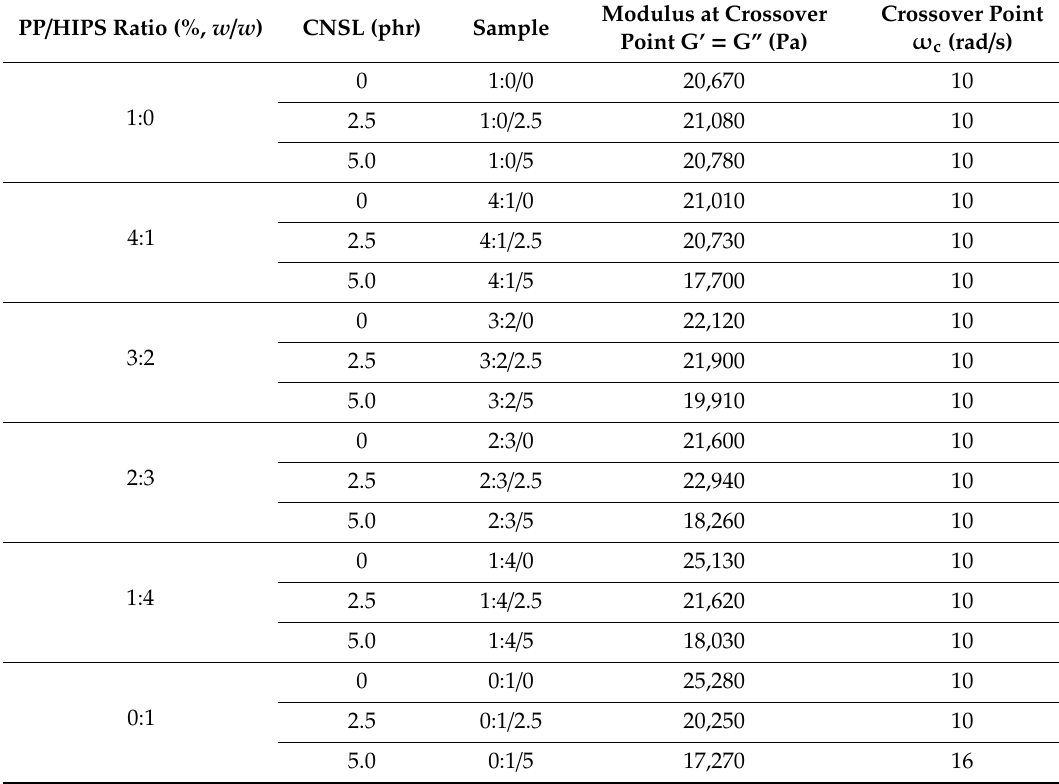
Table 5. Dynamic modulus and frequency values at the G’ / G” crossover point for neat PP, HIPS and blends with 0, 2.5 and 5.0 phr CNSL